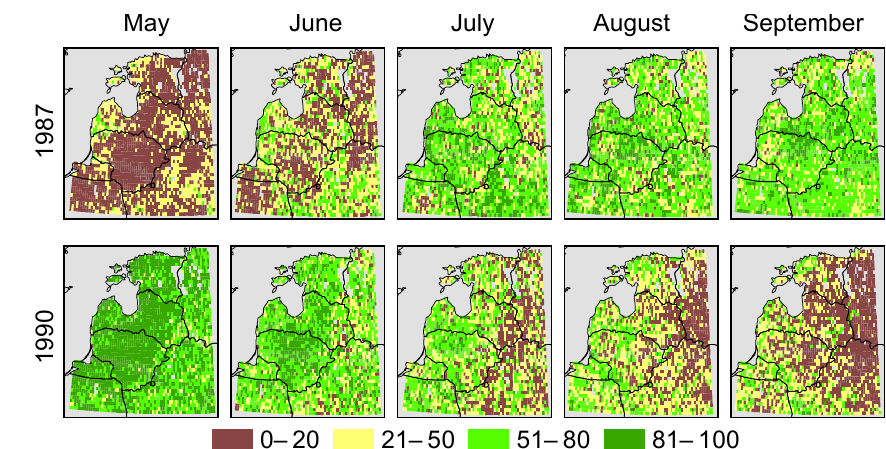
Figure 4. Vegetation condition index (VCI) during the years with cold winter and spring (1987) and warm winter and spring (1990).